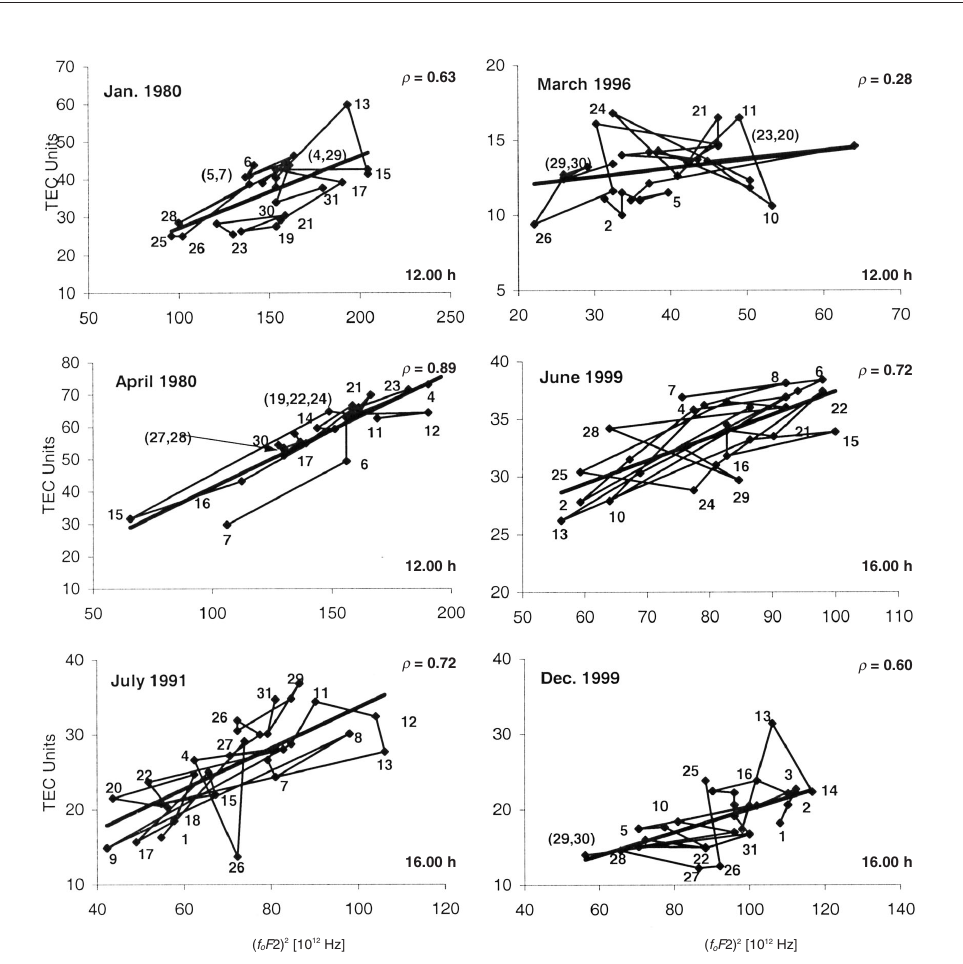
Fig. 3. Linear correlation between TEC Faraday rotation ( left ), GPS ( right ) and ( f o F 2) 2 hourly daily values at some selected months/years, at given hours (12.00 or 16.00